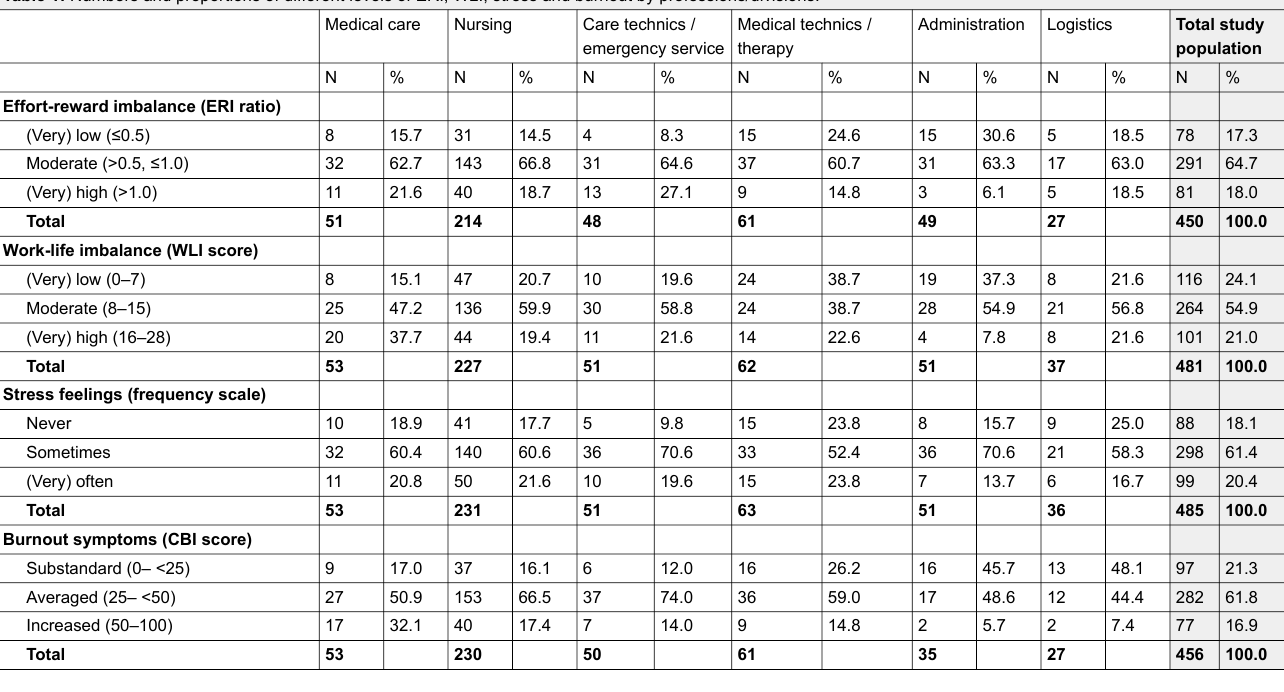
Table 1: Numbers and proportions of different levels of ERI, WLI, stress and burnout by professions/divisions. Medical care